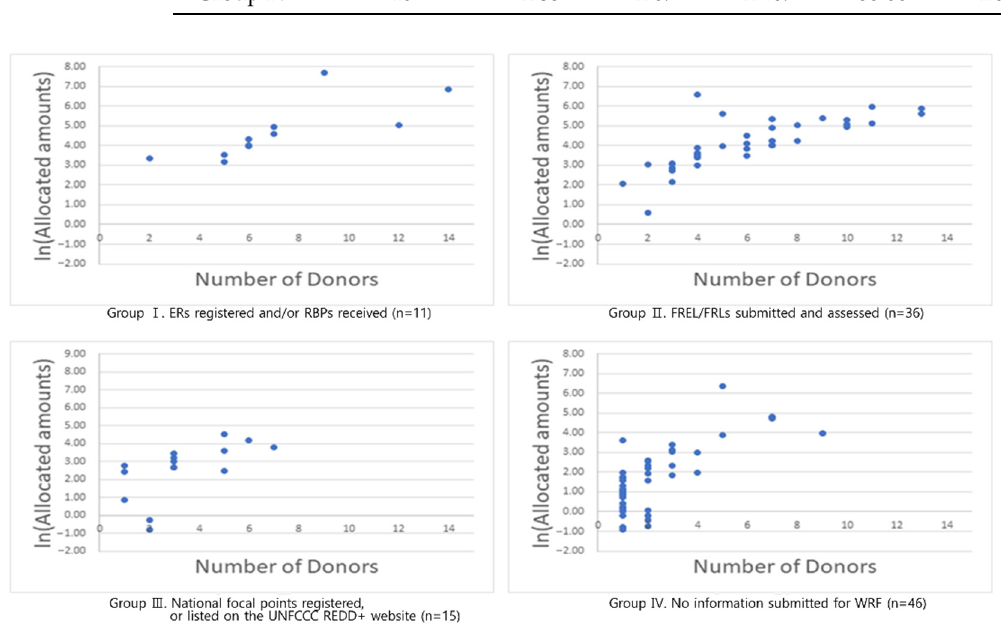
Figure 3. Number of donors and allocated amounts by recipient groups.